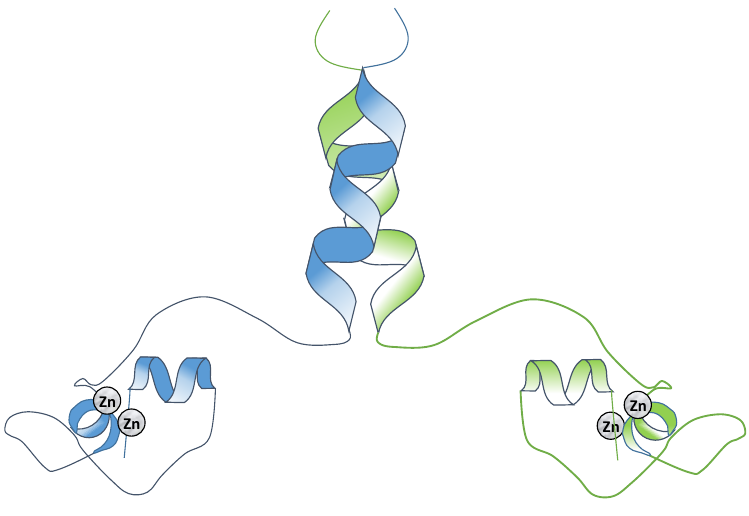
Figure 5. Dimeric structure of the Gal4p Zn 2 C 6 transcription factor.